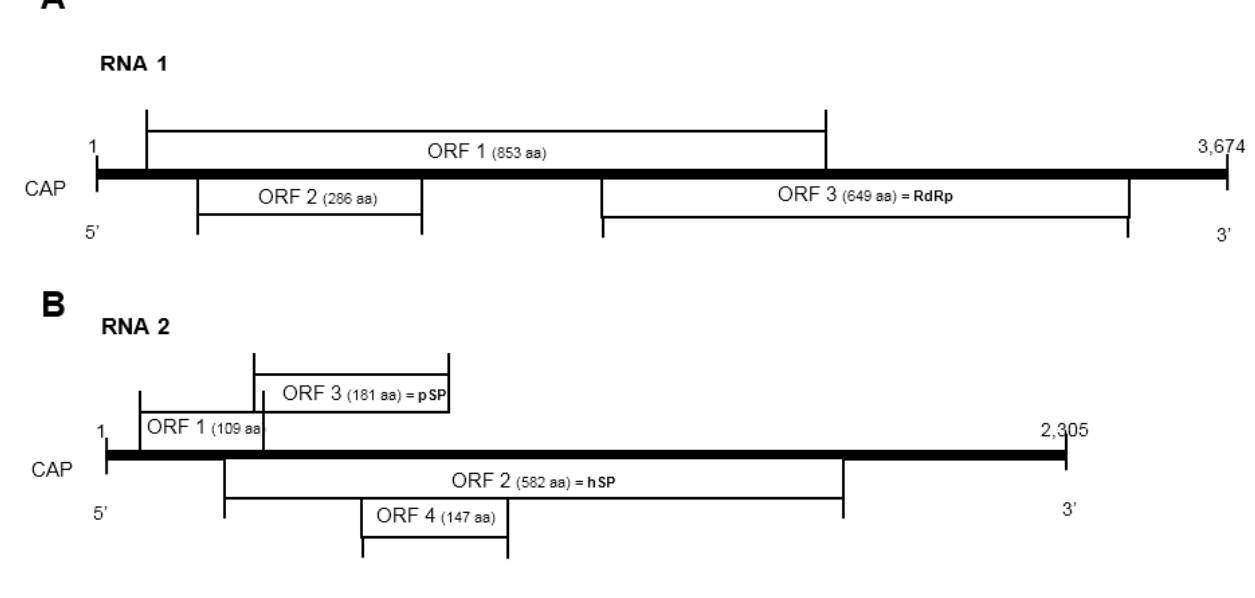
Figure 1. Diagram of the predicted genome organization of CBPV RNA 1 ( A ) and RNA 2 ( B ). Seven putative ORFs are indicated with their positions and putative amino acid sequence length. aa: Amino acid; RdRp: RNA-dependent RNA polymerase; pSP: predicted structural protein; hSP: hypothetical structural